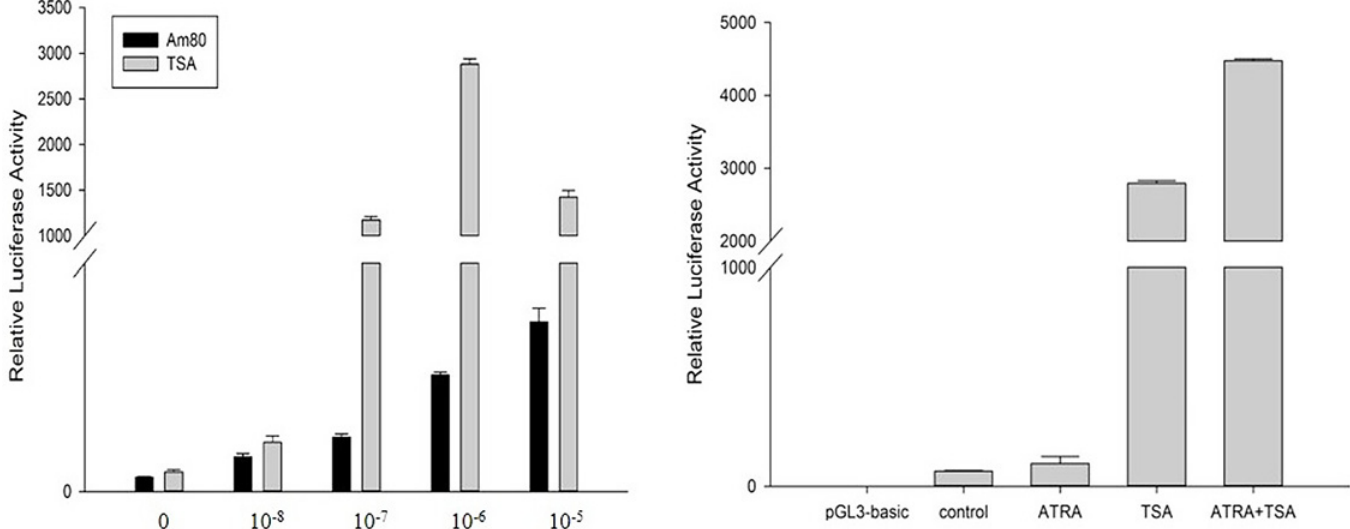
Fig 3. Effects of the induction of Am80 and TSA on the Stra8 promoter activity. A: Effect of different concentrations of Am80 and TSA on Stra8 promoter activity. B: Effect of Am80 (10 − 5 mol/L) or TSA (10 − 6 mol/L) on Stra8 promoter activity. ** P < 0.01.